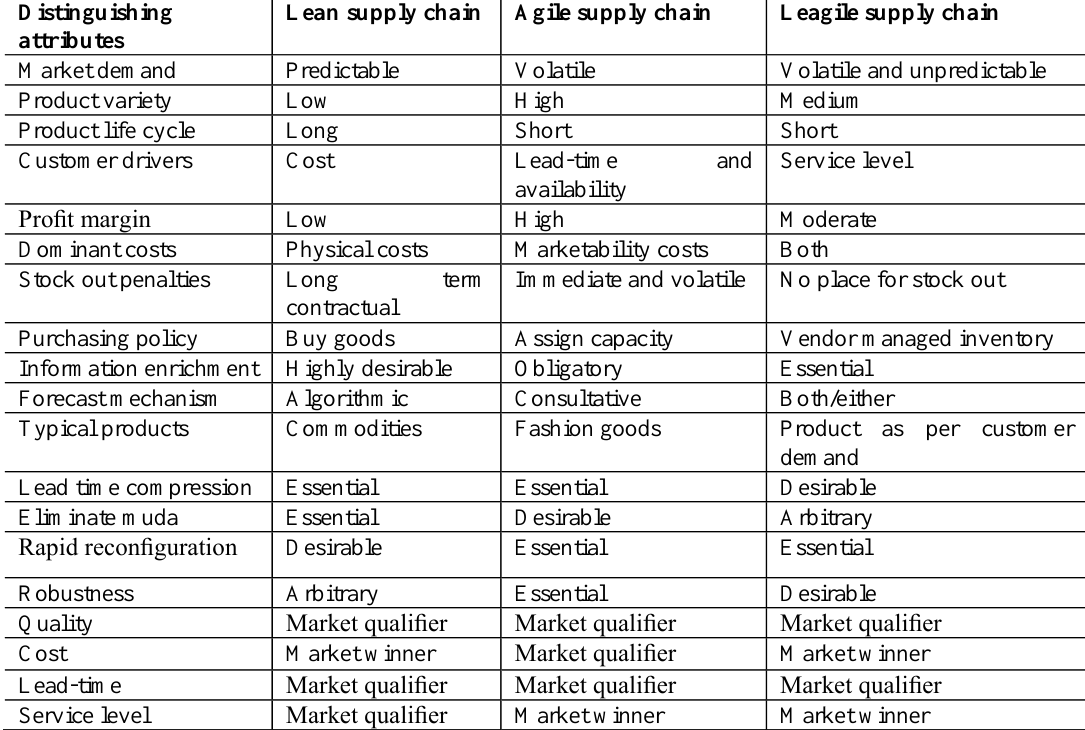
Table A2. Difference between lean, agile and leagile supply